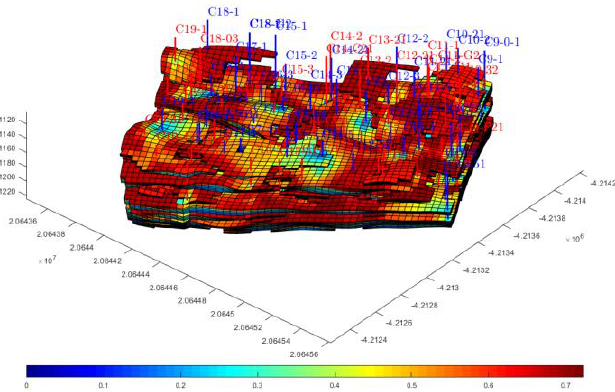
Figure 10. The remaining oil saturation distribution calculated by the new simulator.